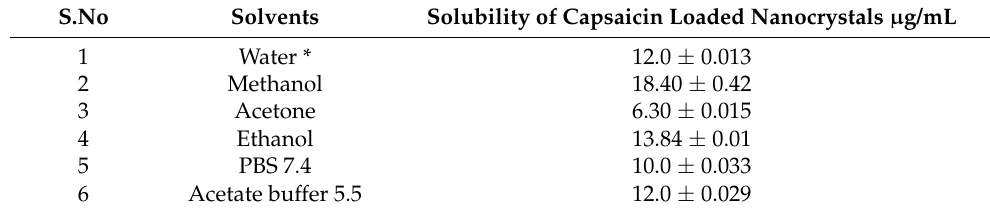
Figure 3. XRD thermo ‐ gram of ( a ) Pure Capsaicin and ( b ) Capsaicin loaded nano ‐ crystal formulation. Table 4. Solubility of Capsaicin loaded nanocrystals in different solvents.